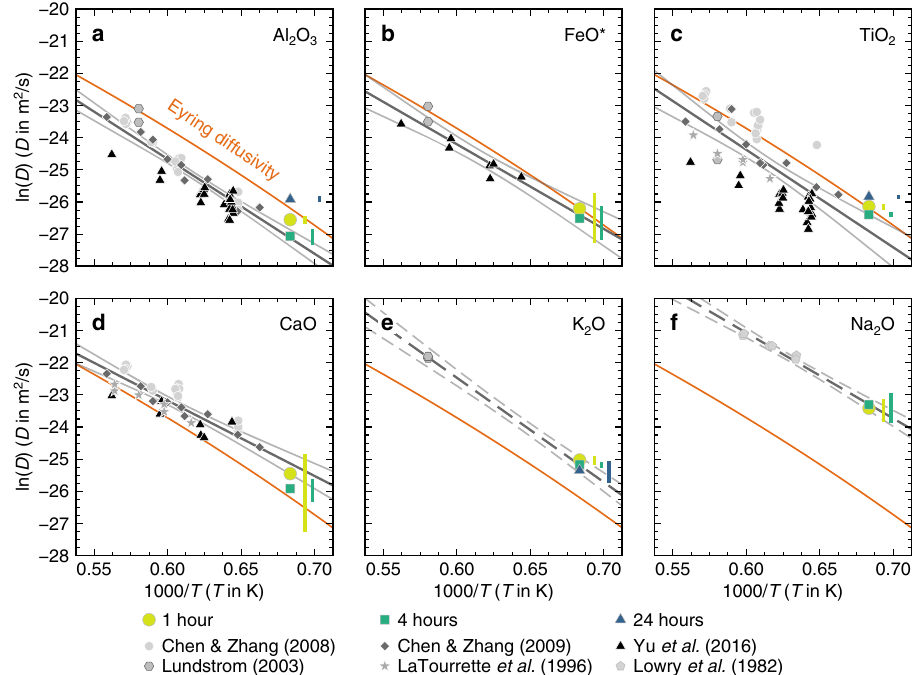
Fig. 7 Element diffusivities in basaltic melts. Effective binary diffusion coef fi cients ( D ) were estimated by fi tting error functions to glass composition pro fi les to solve Fick ’ s 2 nd Law, and are summarised in 1000/ T versus ln( D ) space alongside published diffusivities from experiments on basaltic systems 35 – 38,46,47 . Diffusion coef fi cients estimated from our experiments are only presented for element-duration combinations for which composition pro fi les were clearly sigmoidal in form. Temperature- and viscosity-dependent Eyring diffusivities calculated with a characteristic diffusive jump length of 0.4 nm are shown as orange lines 34,51 . Grey lines show regressions with 95% con fi dence intervals through global datasets. Dashed lines show tentative regressions for elements with sparse diffusion data. Vertical coloured bars show 1 σ uncertainties in diffusion coef fi cients that are offset for clarity. a Estimated Al 2 O 3 diffusivities are broadly consistent with Eyring diffusivities and slightly faster than from published diffusivities 36 – 38,46 . b Estimated FeO* diffusivities are similar to Eyring diffusivities and consistent with published diffusivities 38,46 c Estimated TiO 2 diffusivities are similar to Eyring diffusivities and consistent with many published diffusivities, though published values span up to three ln units at any given temeprature 35 – 38,46 . d Estimated CaO diffusivities are slightly faster than Eyring diffusivities but appear slightly slower than published diffusivities 35 – 38 . e Estimated K 2 O diffusivities are a ln unit faster than Eyring diffusivities but de fi ne a plausible array in 1000/ T versus ln( D ) space with the limited number of published diffusivities available 46 . f Estimated Na 2 O diffusivities are three ln units faster than Eyring diffusivities. They are also coherent with some published diffusivities 47 , but not others 37